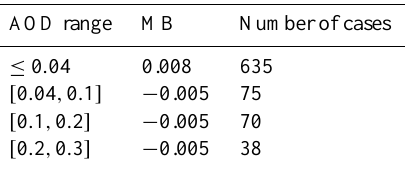
Table 3. Mean bias (MB) and number of cases of the daily coinci- dent comparison between PFR and Mark-I (transmitted component) AOD extracted during